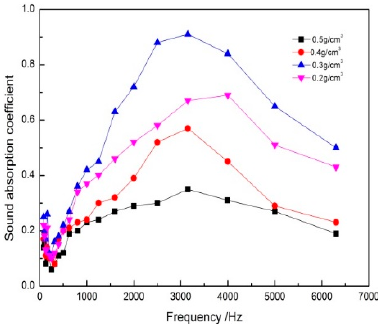
Figure 6. Effect of density of composites on sound absorption coefficient.